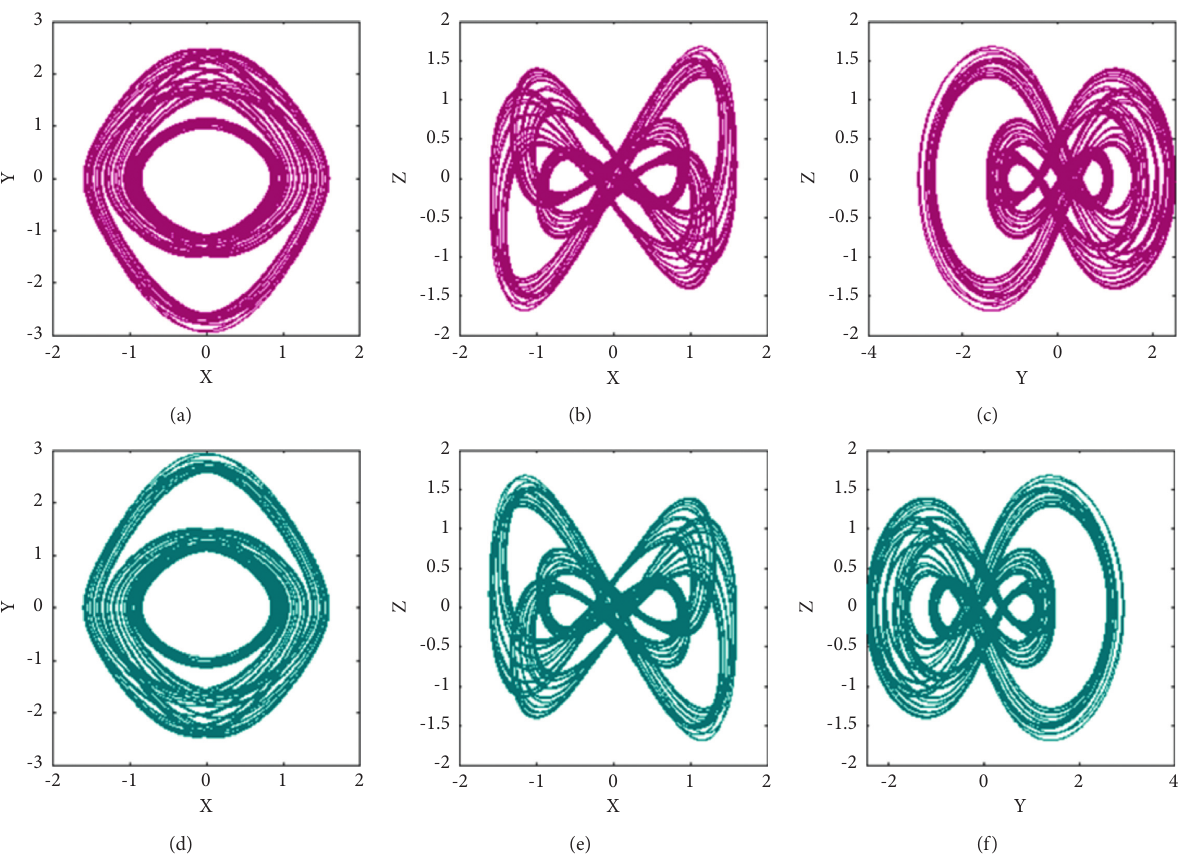
Figure 2: Chaotic sea of the oscillator with initial conditions (− 0 . 57 , − 0 . 99 , − 0 . 71 ) , (a) in X − Y , (b) in X − Z , and (c) in Y − Z , and with initial conditions ( 0 . 57 , 0 . 99 , − 0 . 71 ) , (d) in X − Y , (e) in X − Z , and (f) in Y − Z . The two dynamics are symmetric.